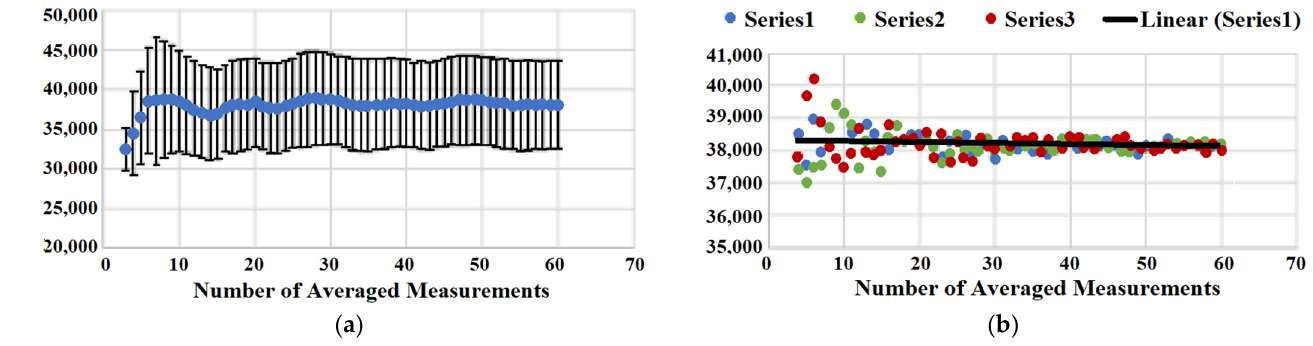
Figure 4. ( a ) Averaged signal intensity (blue points) as a function of averaging the number of measurements and corresponding standard deviation (error bars). ( b ) Three series of random single point removal. Averaged SERS intensity is plotted vs. number of averaged measurements.